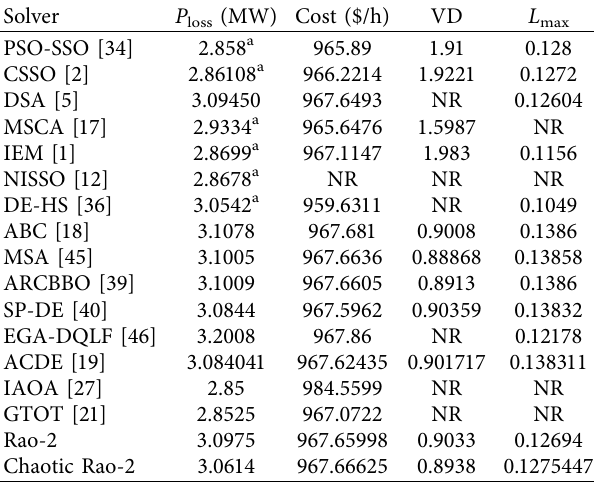
Table 4: Comparison study for case 2. Solver